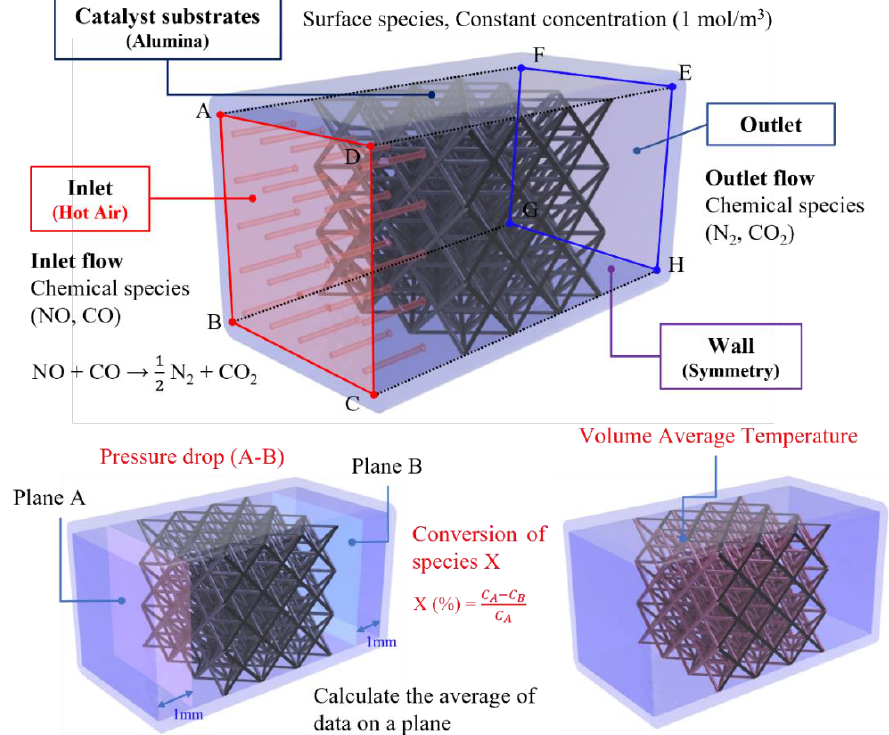
Figure 2. Schematic of the computational domain and boundary conditions and calculation of the conversion.